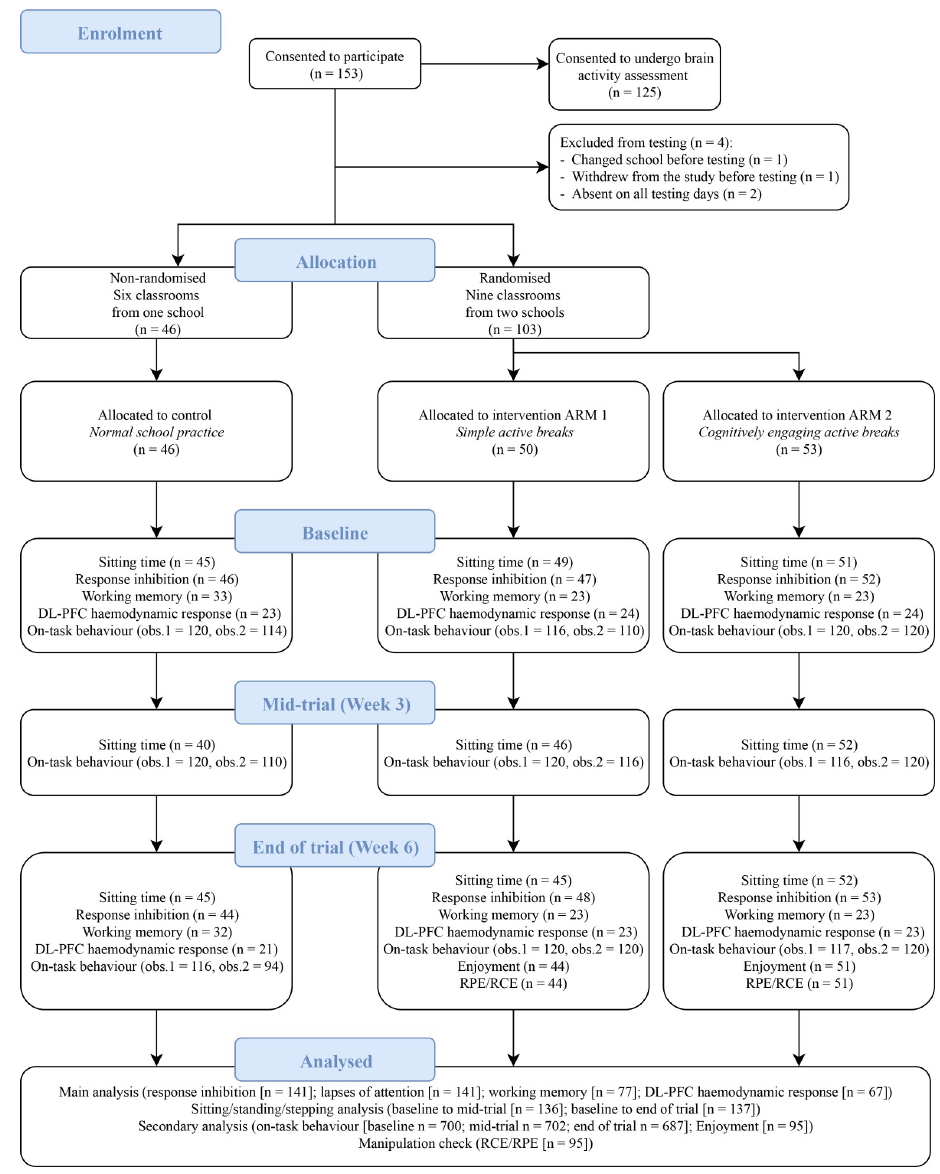
Fig 1. Recruitment flow diagram according to the Consolidated Standards of Reporting Trials (CONSORT) [59]. Working memory assessment was limited to a total sub-sample of 79 children randomly allocated, from the total sample of 153 children, due to the limited time available to complete this assessment. Dorsolateral prefrontal cortex (DL-PFC) haemodynamic response assessment was limited to a random sub-sample of 71 children, out of the 125 who provided additional consent to undergo the DL-PFC haemodynamic response assessment, due to the limited time available to complete this assessment. At each time point, on-task behaviour was assessed with six children randomly selected from each group (one classroom per study group); for this assessment, two consecutive 30-min observations were completed at each time point. Rating of perceived physical effort (RPE); rating of perceived cognitive effort